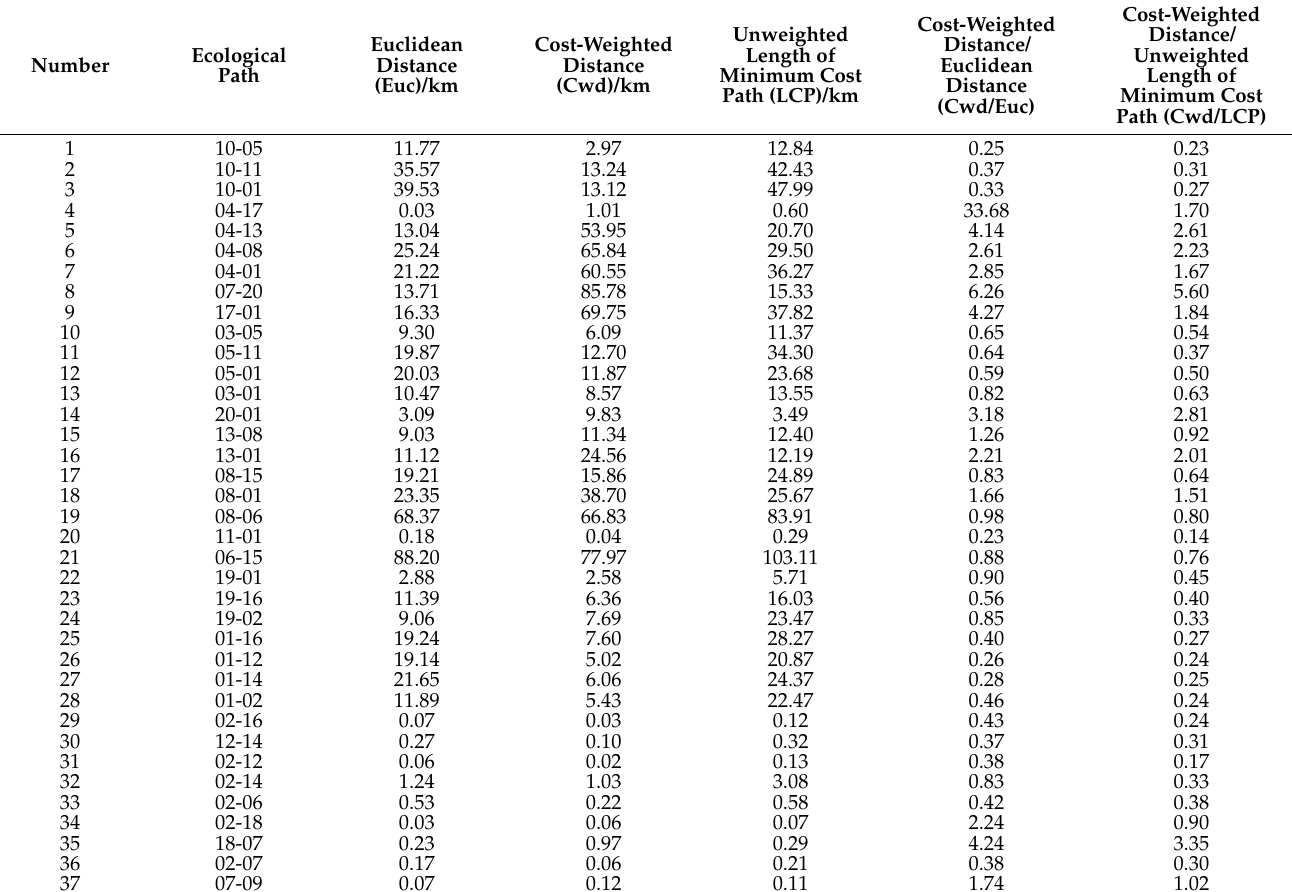
Table 6. Ecological corridor path and distance